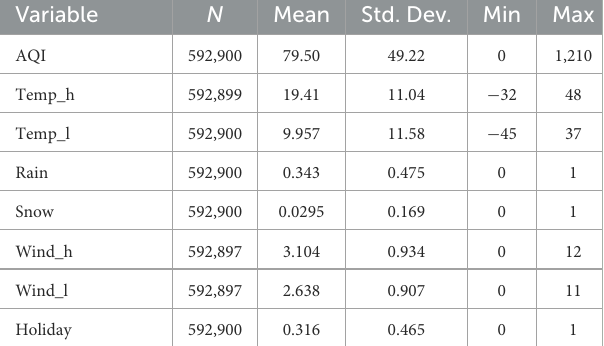
FIGURE2 Test of density function